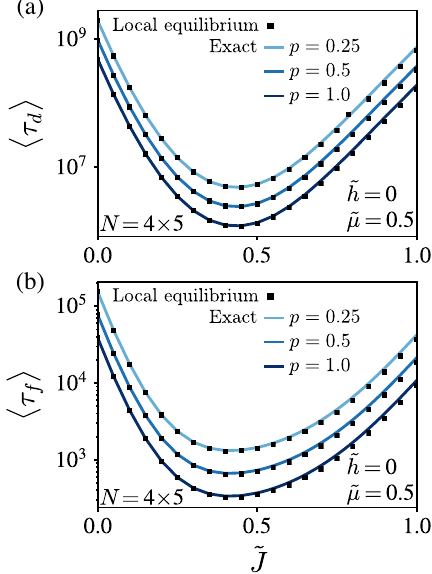
FIG. 7. Kinetics of dissolution and formation of small clusters. Mean first passage time for (a) cluster dissolution and (b) for- ˜ J mation as a function of the coupling for N ¼ 4 × 5 adhesion bonds with intrinsic affinity ˜ μ ¼ 0 . 5 in the absence of a force (for nonzero force values, see Fig. 16). Colored lines correspond to exact results obtained from Eq. (E2) for various values of the Glauber attempt probability p , which we set to be constant → p , and symbols denote the local equilibrium approximation p k Eq. (23) evaluated with the exact Q and ¯ w from Eqs. (6) k k → k (cid:2) 1 and (21),